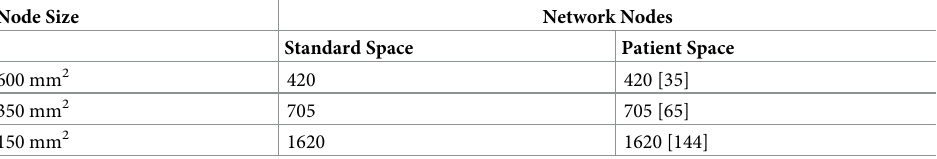
Table 3. Summary of network sizes when constructed in standard space and patient space.